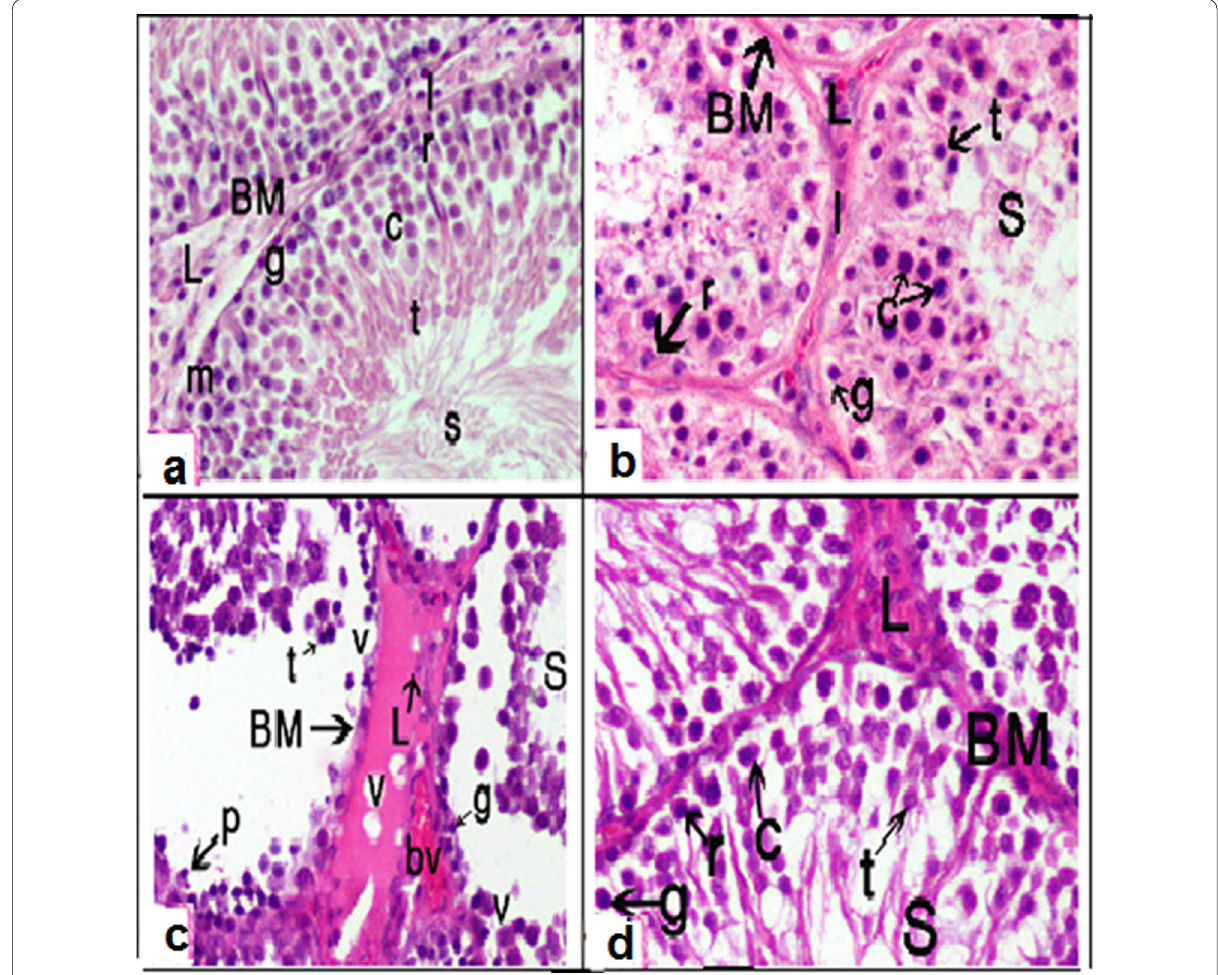
Fig. 1 a Light micrographs (LM) a transverse section of a control group of rats of testis showing seminiferous tubules lined with basement membrane (BM) had myoid cells (m), interstitial tissue (I) among the tubules, spermatogonia appeared as small, rounded cells (g), primary spermatocyte as large, rounded nuclei (c). Spermatids as small, rounded cells with pale nuclei (t); Sertoli cells have triangular nuclei attached to the basement membrane (r), sperms (S) in the center, and Leydig cells (L). (Hematoxylin and Eosin 400). b Light micrographs (LM) a transverse × section of second groups of rats of testis showing seminiferous tubules lined with basement membrane (BM) had myoid cells (m), interstitial tissue (I) among the tubules, spermatogonia appeared as small, rounded cells (g), primary spermatocyte as large, rounded nuclei (c). Spermatids as small, rounded cells with pale nuclei (t). Sertoli cells had triangular nuclei attached to the basement membrane (r), sperms (S) in the center, and Leydig cells (L). (Hematoxylin and Eosin 400). c Light micrographs (LM) of a transverse section testis of rat third group showed well‑defined × disorganization with necrosis, vacuoles (v) of germ cells (g), degenerated Leydig cells (L), and degenerated basement membrane (BM), congested blood vessels (bv). (Hematoxylin and Eosin 400). d Light micrographs (LM) of the transverse section of testis of the fourth group showed the × normal structure of spermatogonia cells (g) with normal basement membrane (BM); Sertoli cells (r) and Leydig cells (L) normal spermatocytes c), spermatid (t) and sperms (S). (Hematoxylin and Eosin ×